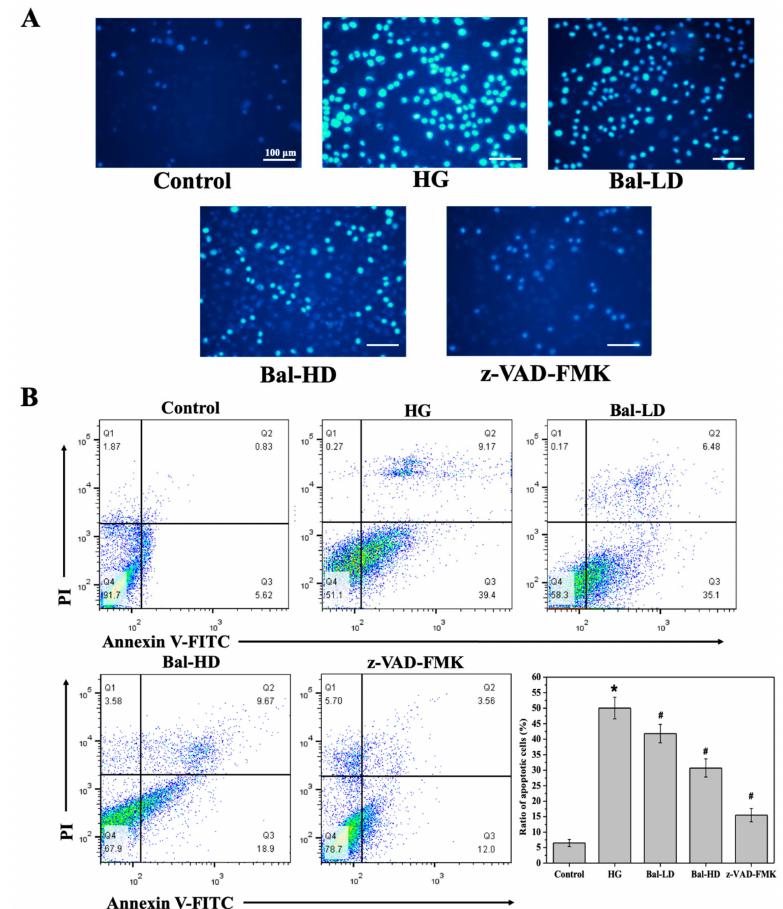
Figure 5. The e ff ect of baicalein on the apoptosis of HL-7702 cells induced by 60.5 mM of glucose. HL-7702 cells were exposed to 5.5 mM of glucose (Control), 60.5 mM of glucose (HG), 60.5 mM of glucose with 5 µ M of baicalein (Bal-LD), 60.5 mM of glucose with 20 µ M of baicalein (Bal-HD), and 60.5 mM of glucose with a pan-caspase inhibitor (z-VAD-FMK) for 24 h. The level of apoptosis in each group was determined. ( A ) Fluorescence images showed the apoptosis levels in the HL-7702 cells stained with Hoechst 33824. Apoptotic cells with strong blue fluorescence were observed. ( B ) Quantitative analysis of the level of apoptosis in each group. The cells were stained with AnnexinV-FITC / PI and the apoptosis of the cells in each group was evaluated by flow cytometry. The data are represented as the mean ± SD ( n = 3). * p < 0.05 vs. control group; # p < 0.05 vs. HG